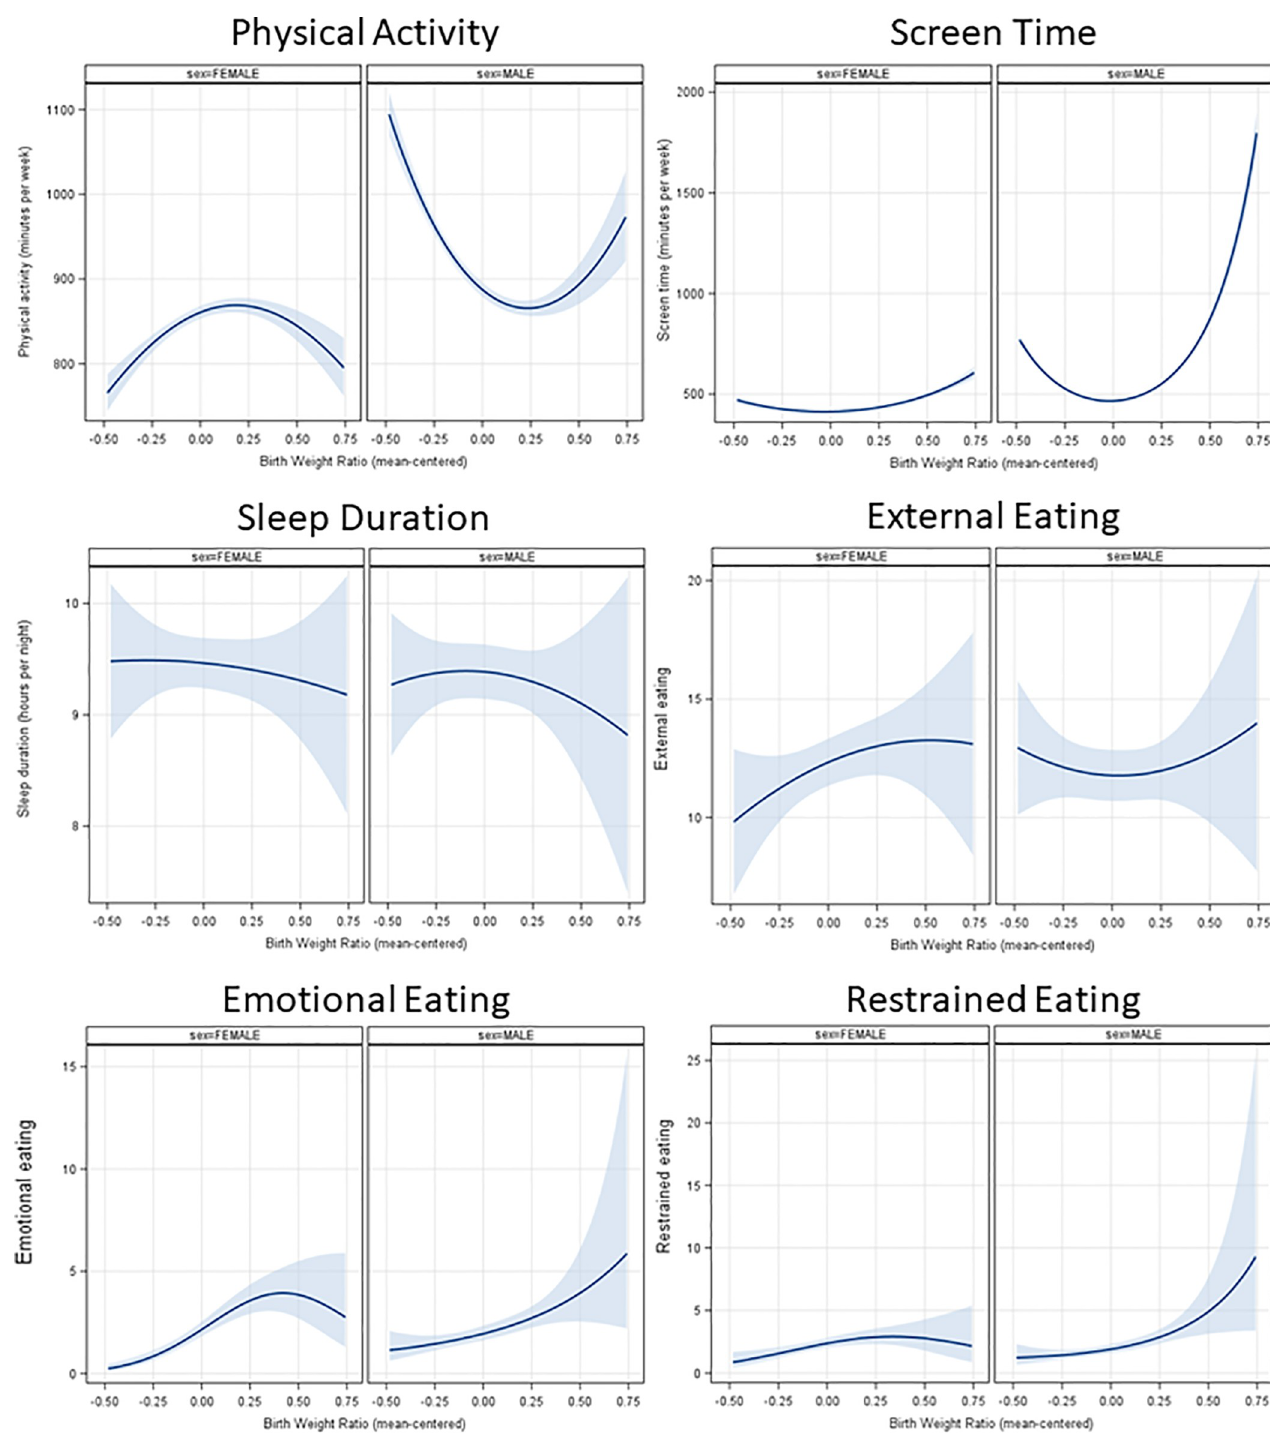
Fig 1. Fitted curves between birth weight ratio and health behaviors by sex. Figure showing fitted curves between Birth Weight Ratio and health behaviors by sex.